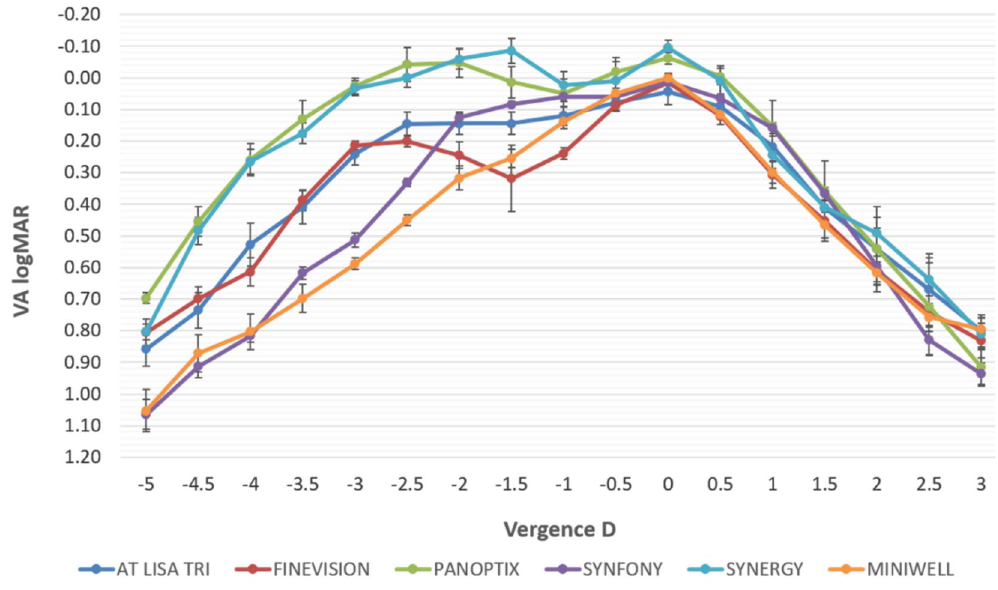
Figure 2. Mean defocus curves obtained in each intraocular lens (IOL)